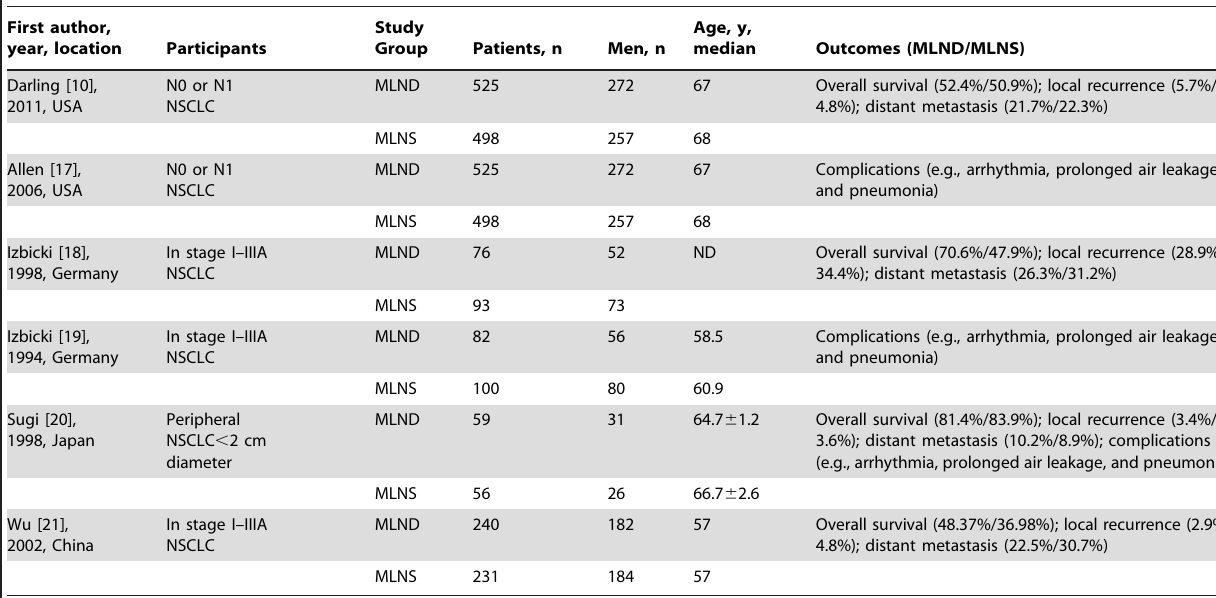
Table 1. Studies included in the